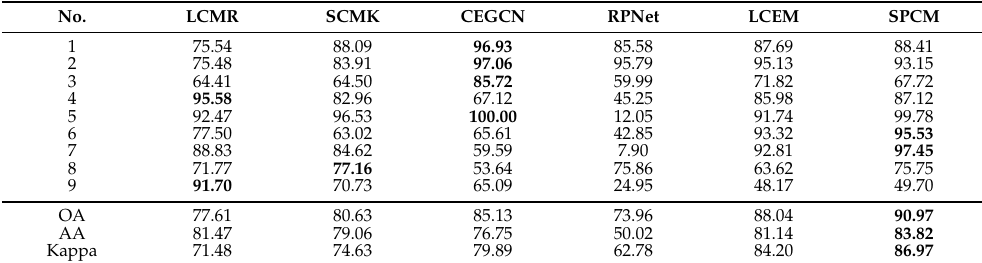
Table 1. Classification results obtained by LCMR, SCMK, CEGCN, RPNet, LCEM, and SPCM using 0.1% of the available labelled data for training with the Pavia University data set. The best results are expressed in bold.